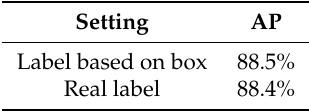
Table 2. The AP for different segmentation